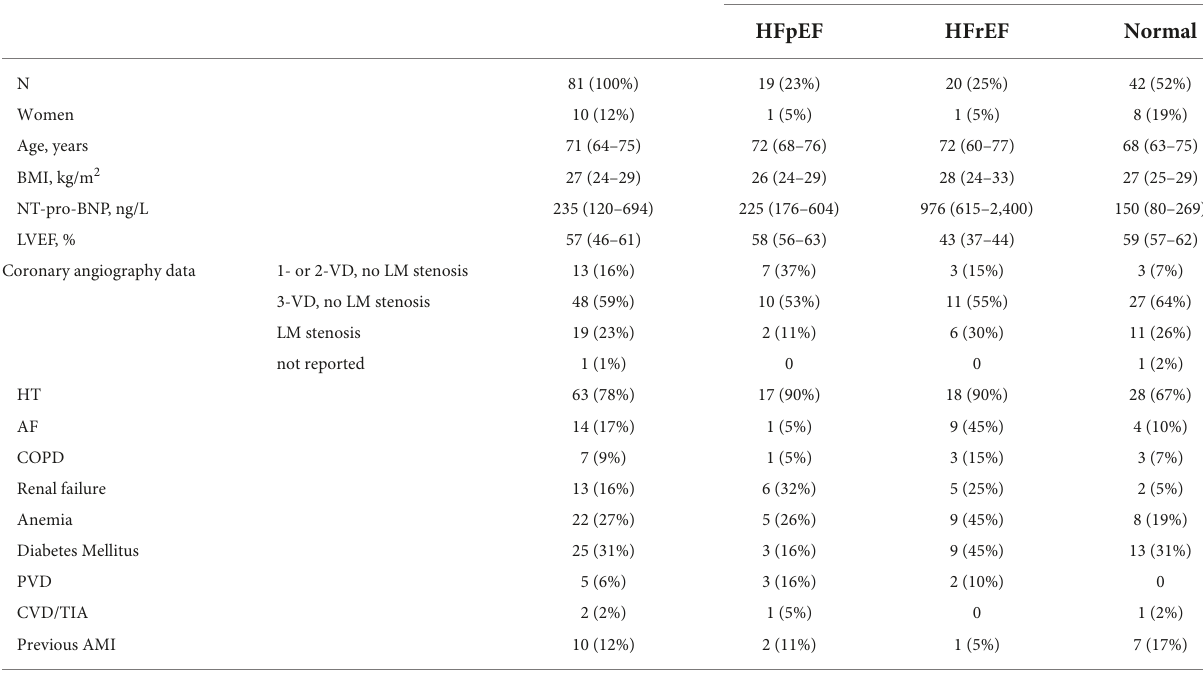
All patients Patient category